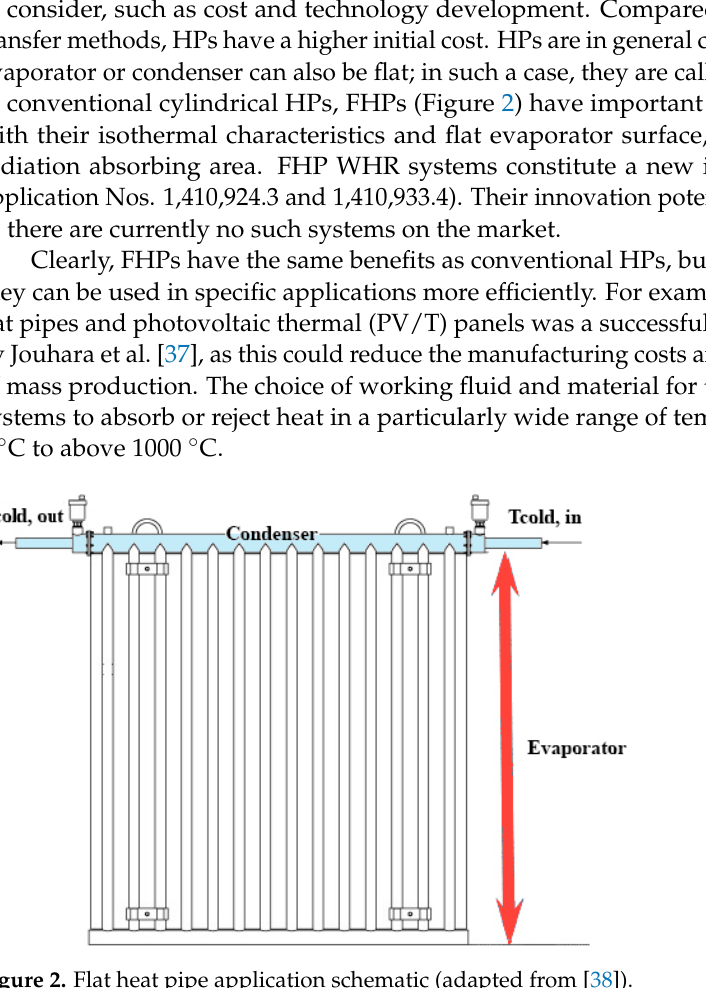
Figure 2. Flat heat pipe application schematic (adapted from [38]).